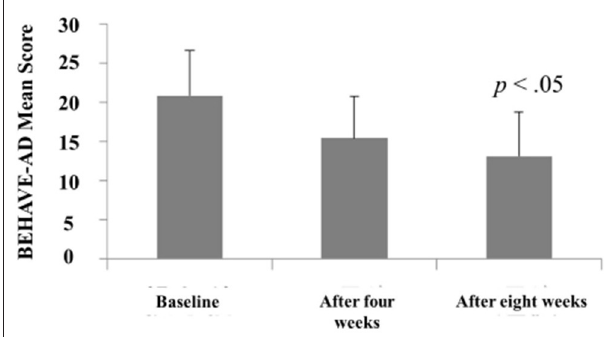
FIGURE 1 | The effects of YKSCH on BPSD ( n = 29). Data were Behave-AD scores (means ± SD and ranges) after YKSCH administration. Three cases with missing data were dropped from the analysis. Post hoc Tukey’s HSD tests were compared to